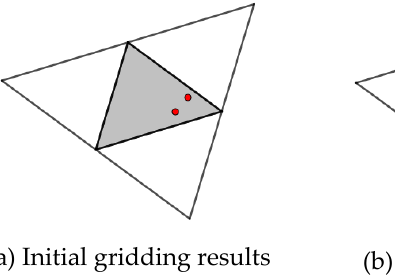
Figure 8. Repair of topological distortion of point features.